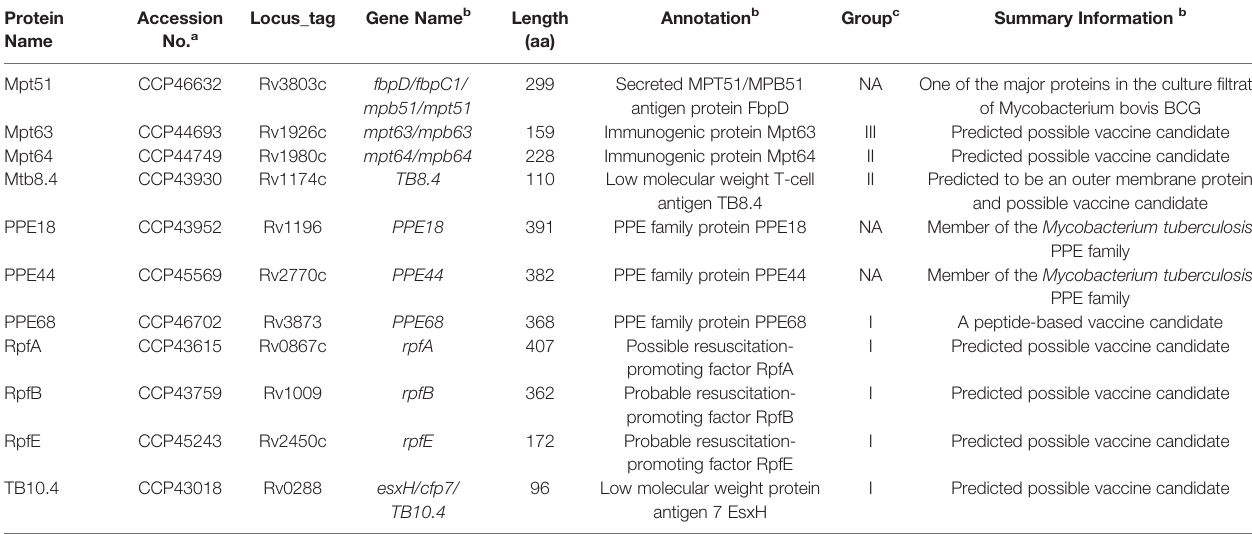
TABLE 1 | The basic information about vaccine candidate proteins of M. tuberculosis